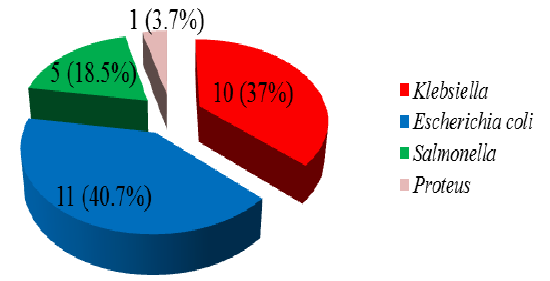
Fig. 3. Antibiogram of 10 generic extended-spectrum β-lactam- resistant Klebsiella isolates from